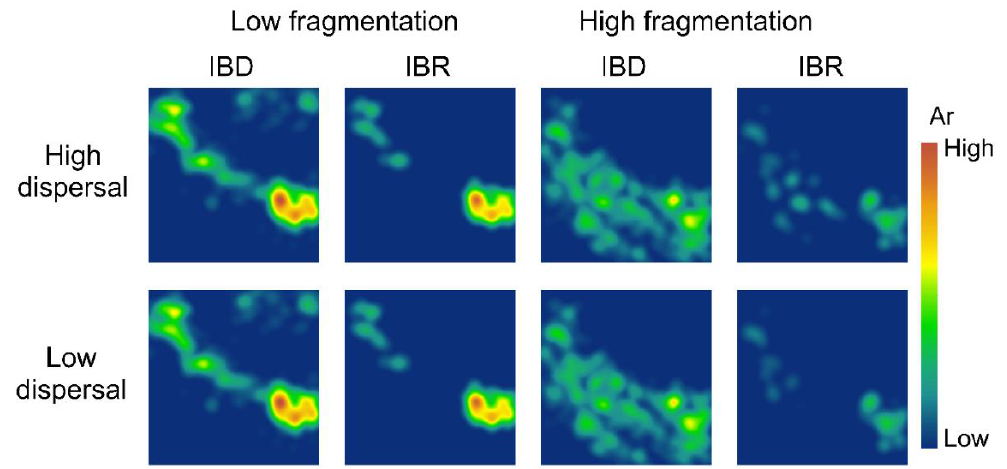
Figure 5. Spatial patterns of allelic richness (A r ) in the low-fragmentation model (left two columns) and the high-fragmentation model (right two columns). Top row: high-dispersal scenario (300 km). Bottom row: low-dispersal scenario (200 km).